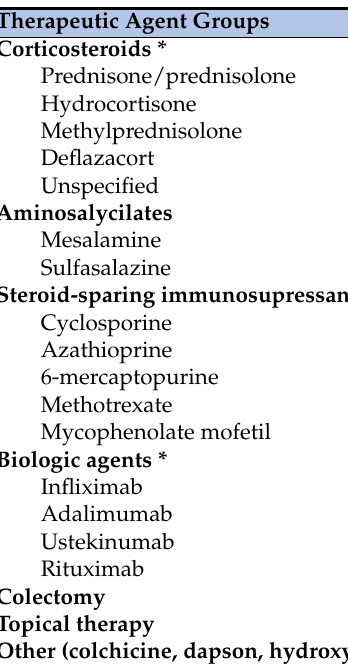
Table 2. Therapeutic options for LCV administered to the patients with UC described in this